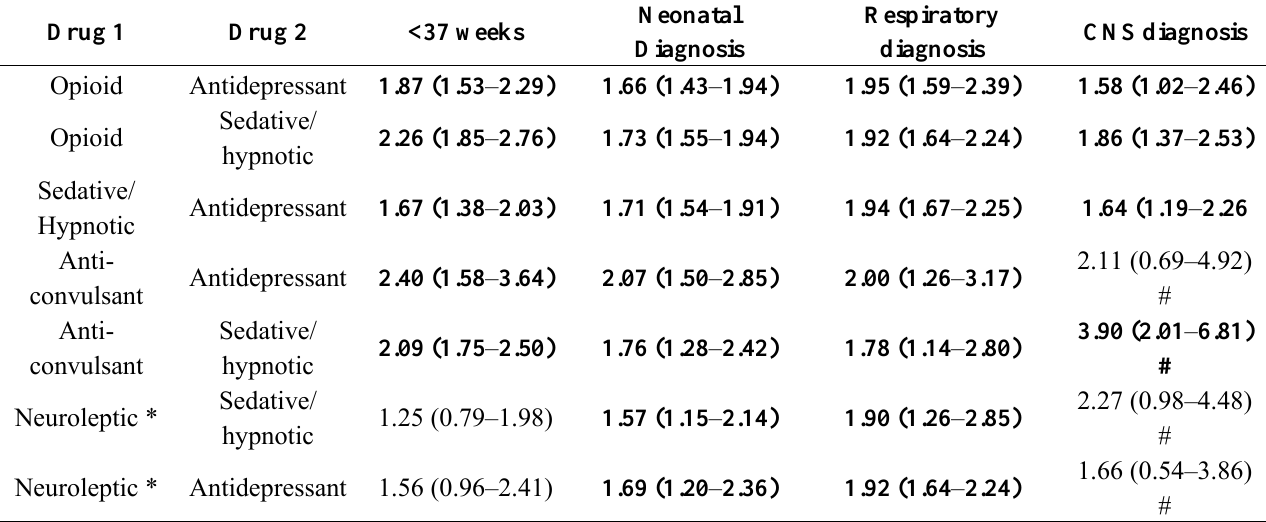
Table 44. Some outcomes for different combinations of CNS-active drugs. Odds ratios given with 95% confidence intervals. Bold text marks statistical significance. For number of exposed infants, see Table